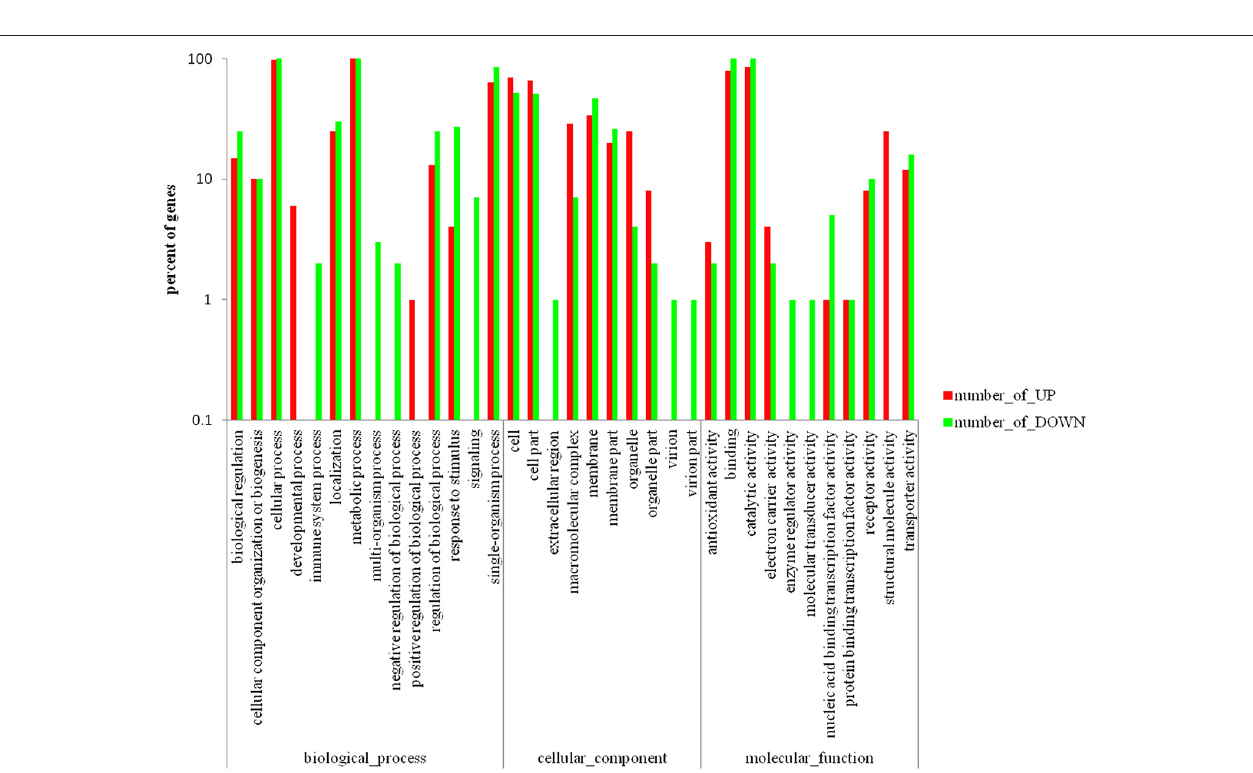
FIGURE 6 | Gene ontology enrichment analysis of the differentially expressed genes scattered to biological-process, cellular-component, and molecular-function, which including 21